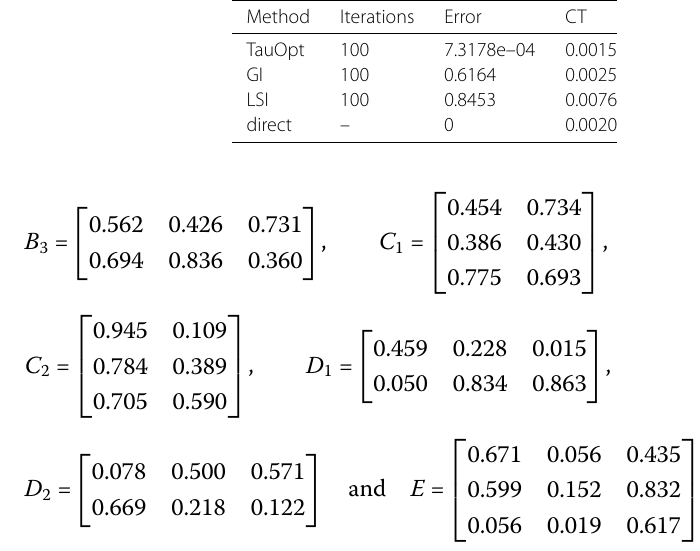
Table 2 Errors and CTs for Ex.